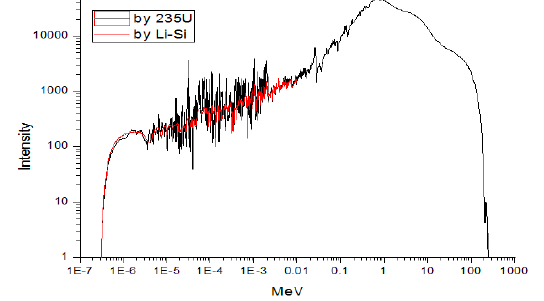
Fig.2. Simulated and measured neutron energy spectra at 76 m from the target (with the Cd filter on)